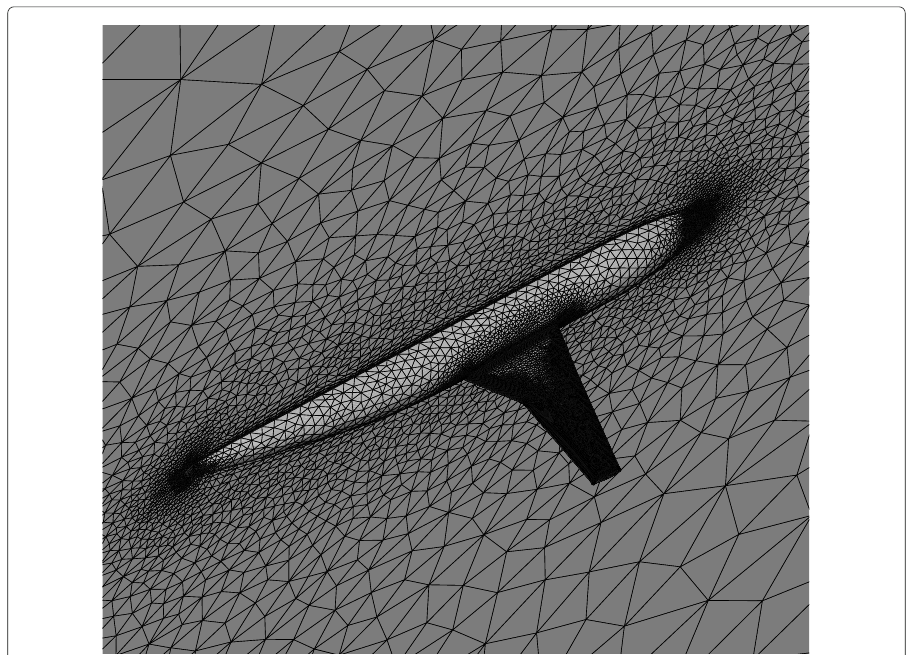
Fig. 14 Mesh for DLR-F4 body test case in the 3D Euler